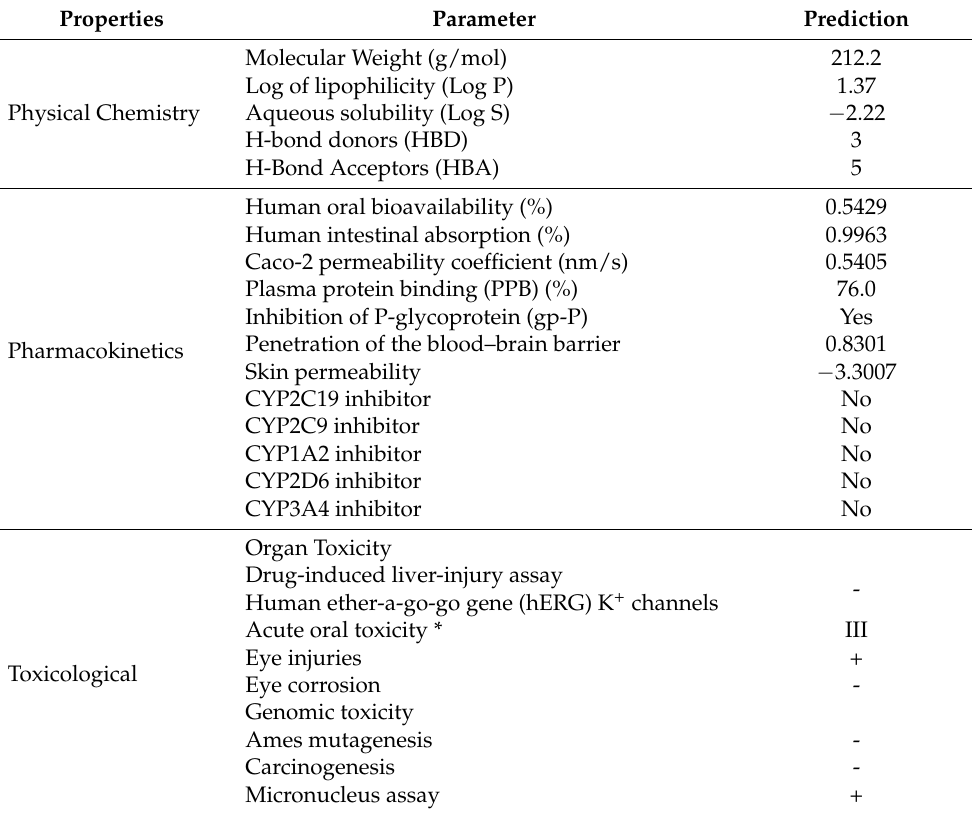
Table 3. In silico ADMET properties of compound